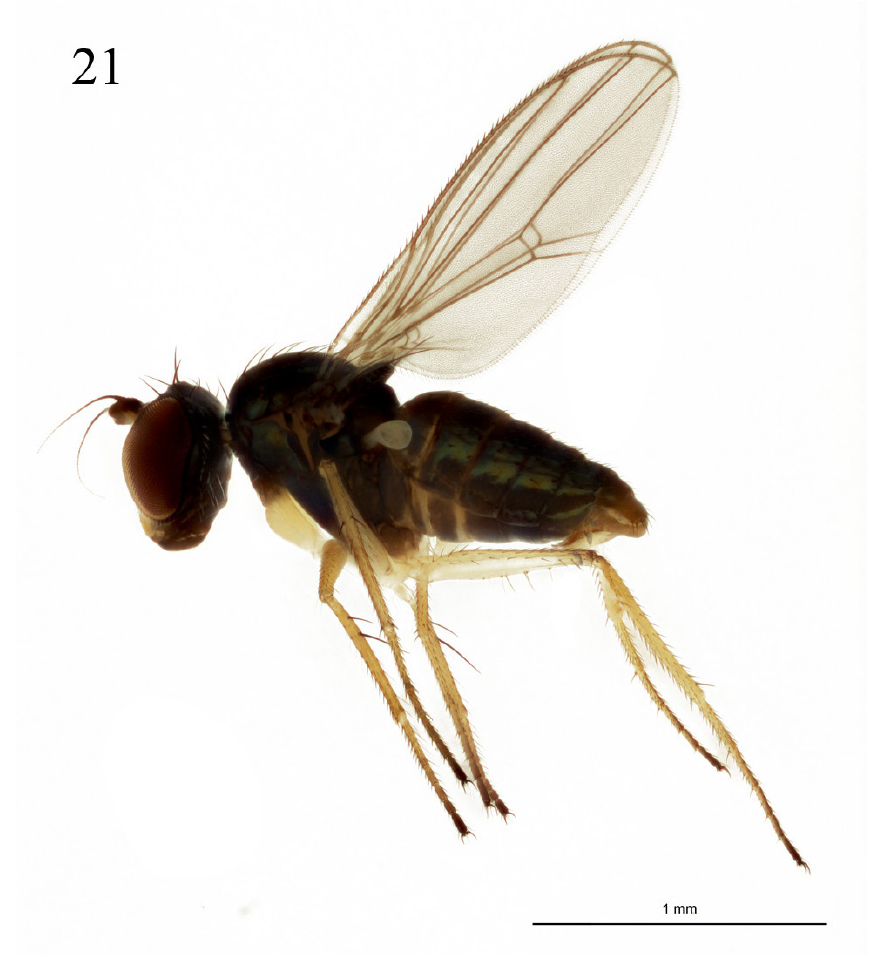
Fig. 21. Thinophilus parvulus sp. nov., ♂,